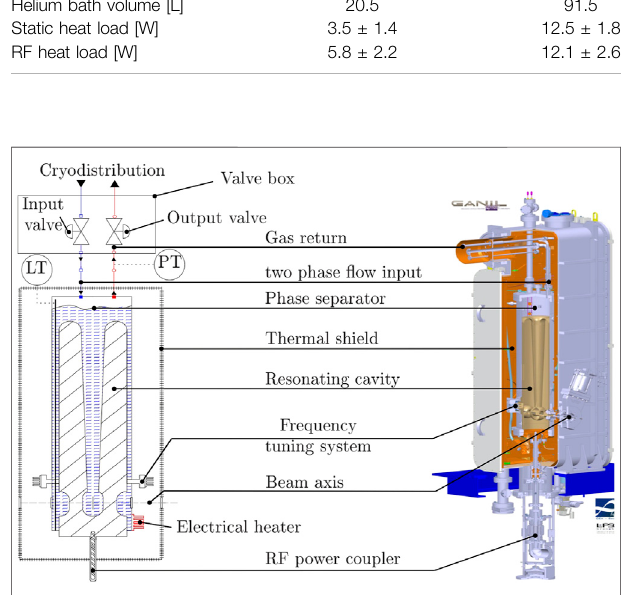
FIGURE 1 | Representation of a type-A cryomodule. On the left is a simpli fi ed scheme. On the right is a 3D cut view. LT and PT are, respectively, level transmitter and pressure